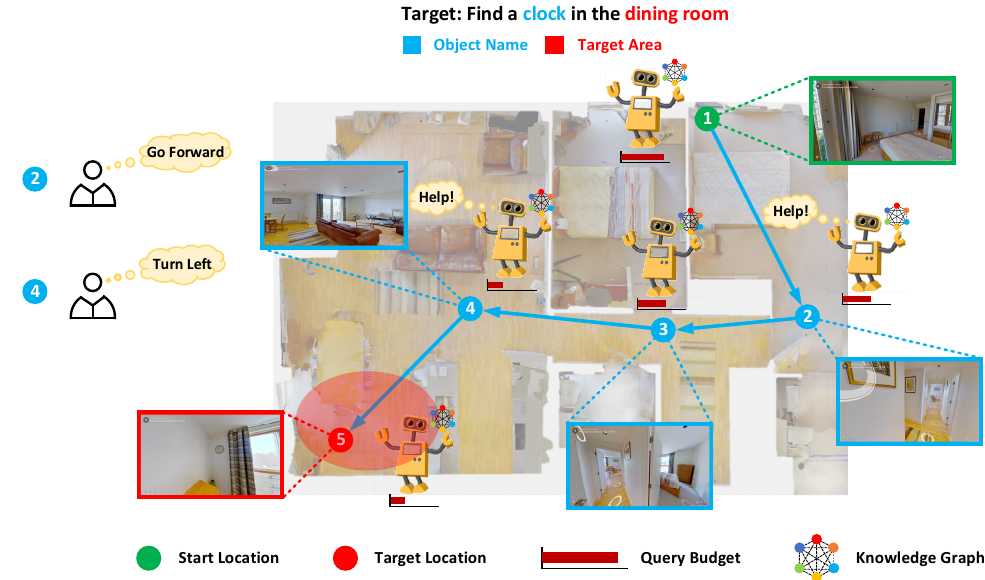
Figure 1. A demonstration of the AKCR-AH navigation process. Initially, the agent stands in the bedroom at “1” and is requested to “Find a clock in the dining room”. The agent begins to navigate with knowledge graph reasoning, but gets lost at “2” in the hallway by the bedroom door, so it signals the simulated human assistant for help. Upon request, the assistant provides a single-step teacher action “Go Forward” through direct intervention. After receiving help, the agent continues to navigate and passes “3”, then reaches the living room. At “4”, the agent gets lost one more time, and its query budget has not been exhausted. It thus asks the assistant for help again. Finally, the agent successfully finds the target object in the dining room at “5” without further assistance and